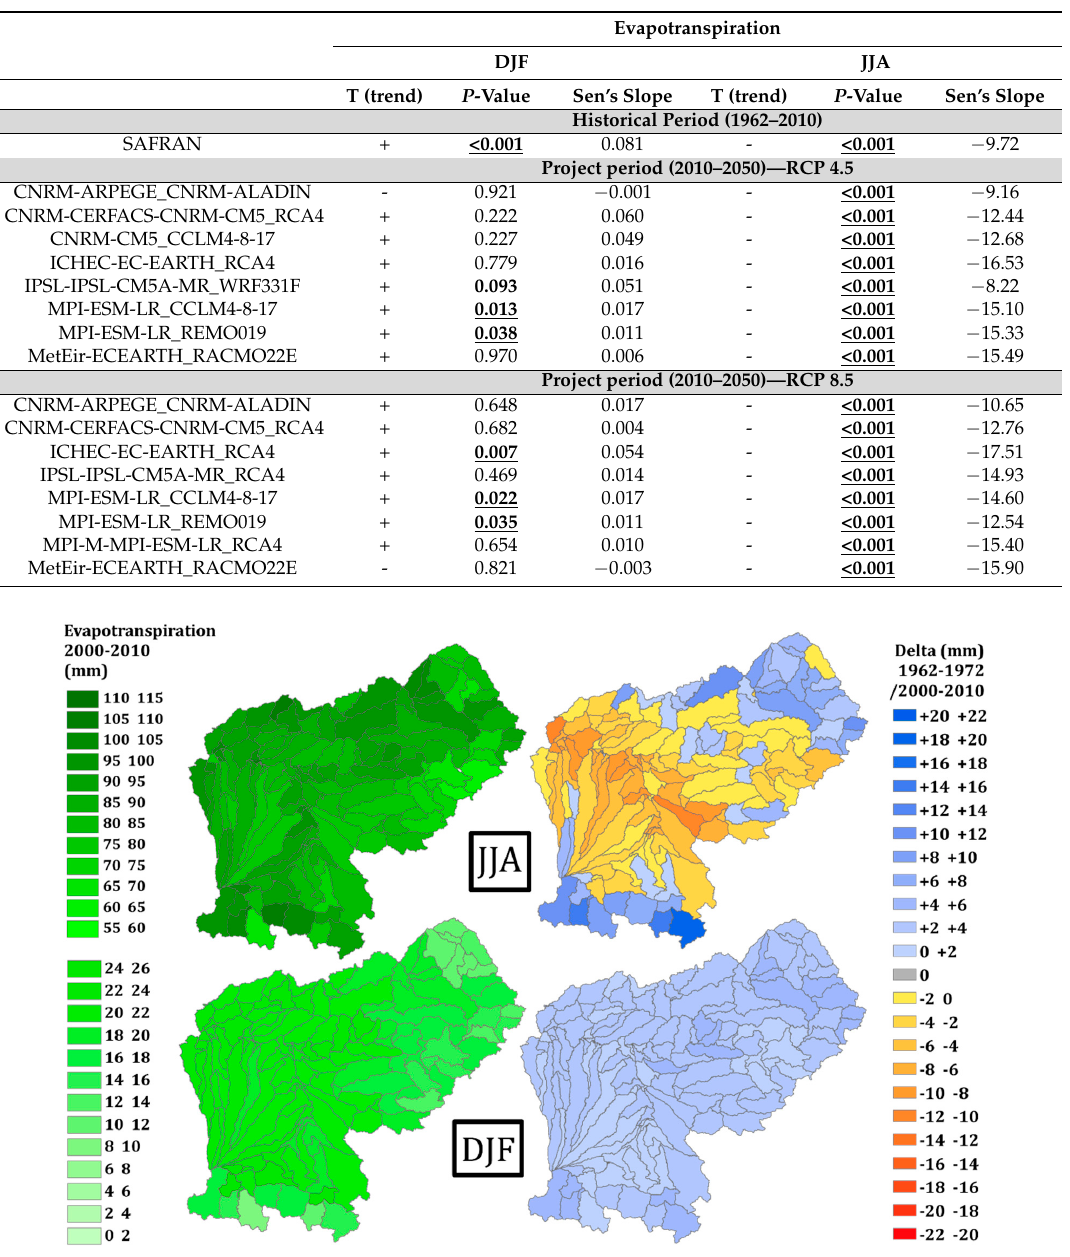
Table 12. Trend in evapotranspiration over winter (DJF) and summer (JJA) seasons at watershed scale, for SAFRAN (historical period) and climatic ensemble (projected period). Bold numbers are significant trend considering α = 0.1 and underlined numbers considering α = 0.05.